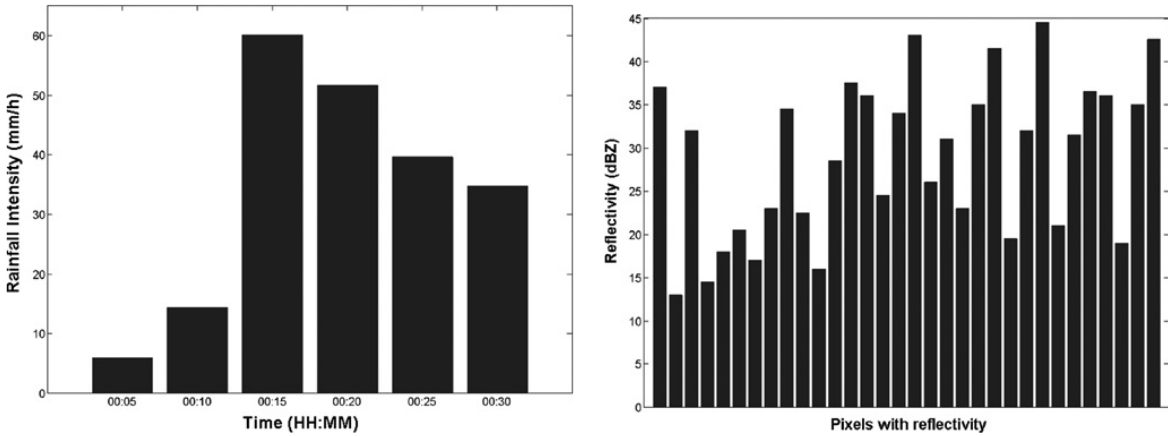
Fig. 4. Examples of a rain gauge (a) and weather radar reflectivity (b) independent window.